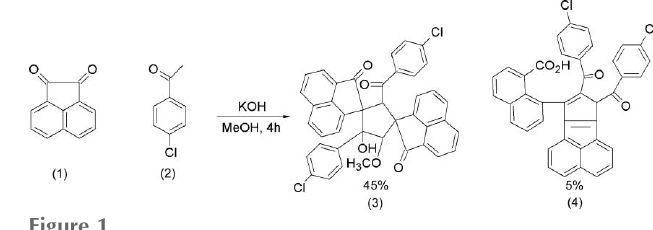
Figure 1 Reaction scheme showing the synthesis of the title compound